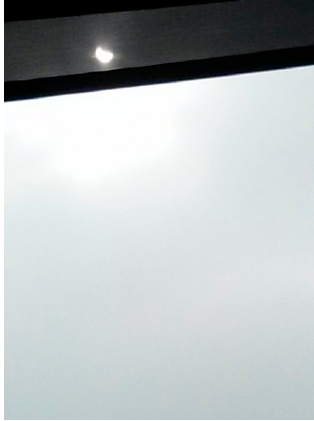
Figure 2. Blind system opacity effect during solar eclipse of 20 March of 2015 in Leuven, Belgium.